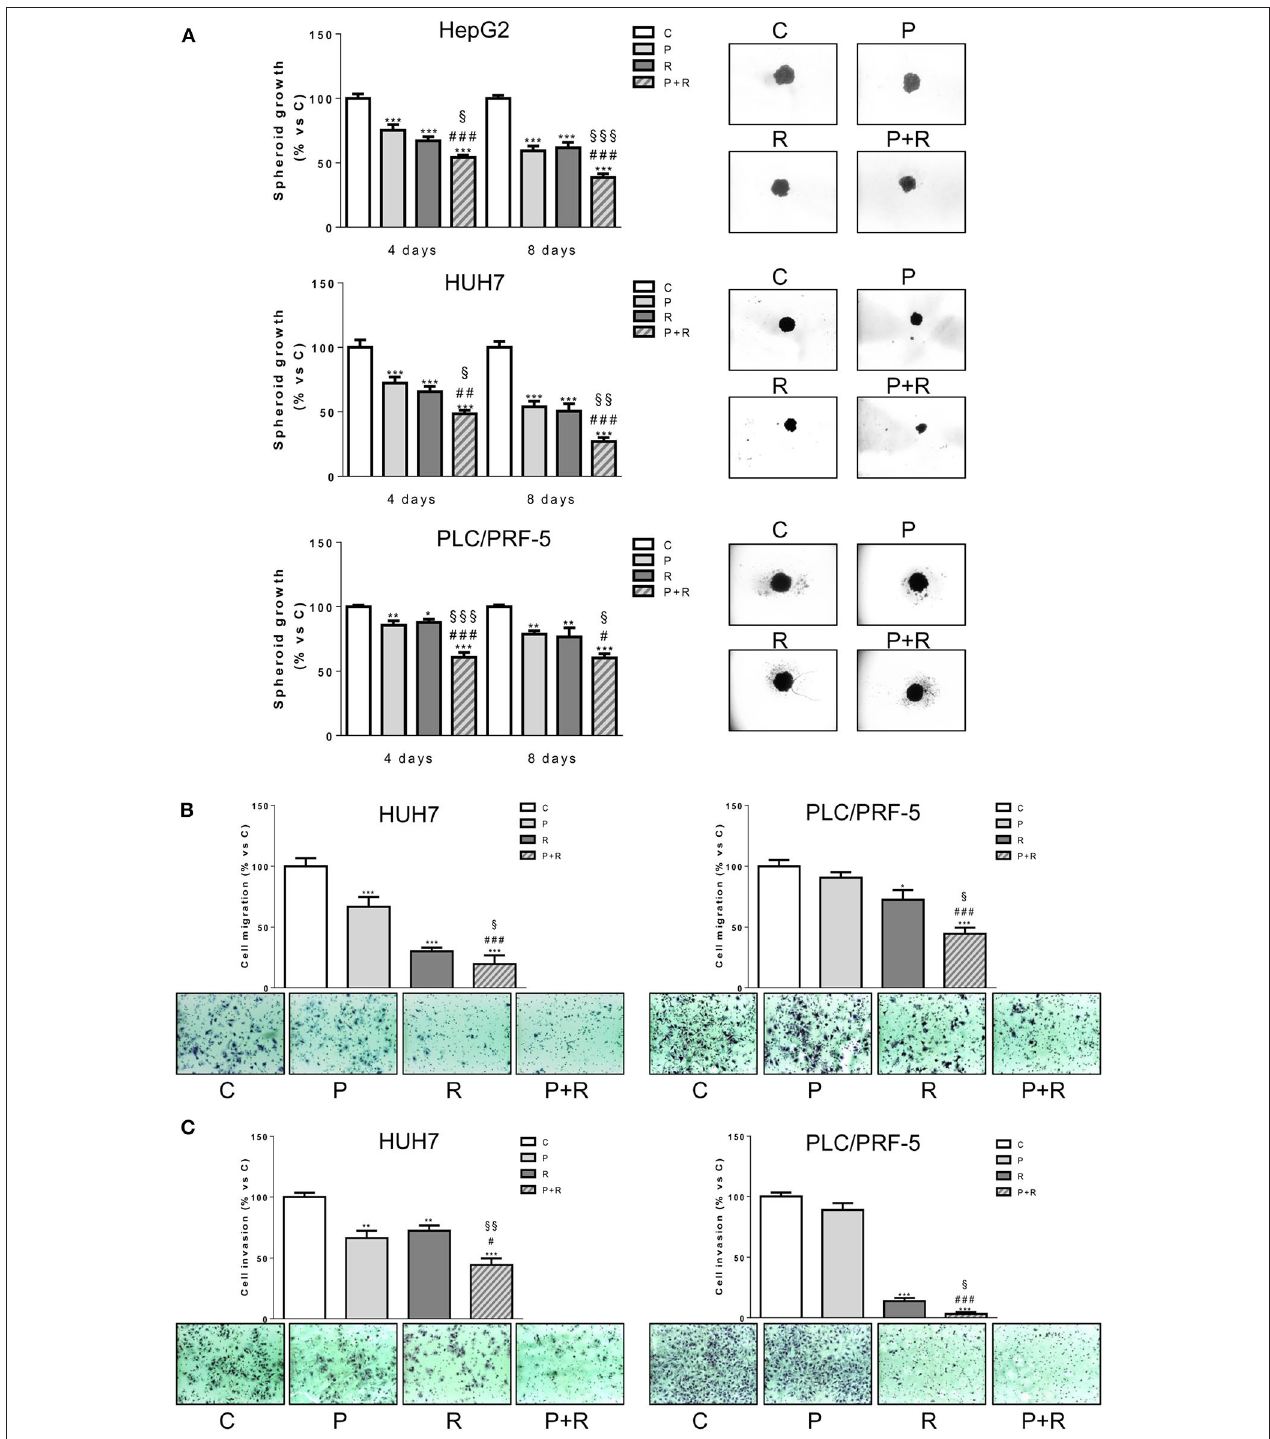
FIGURE 2 | Palbociclib combined with regorafenib inhibits 3D cell growth and reduces cell migration and invasion. (A) The growth of spheroids from HepG2, HUH7, and PLC/PRF-5 was analyzed after 4 or 8 days of treatment with 0.1 µ M P for HepG2 and HUH7, 0.5 µ M P for PLC/PRF-5, and 1, 1.5, or 7 µ M R for HepG2, HUH7, and PLC/PRF-5, respectively, as single treatment or in combination. The data are expressed as percent of spheroid growth vs. control. Representative images of spheroids after 8 days of culture are shown. * p < 0.05, ** p < 0.01, *** p < 0.001 vs. C, # p < 0.05, ## p < 0.01, ### p < 0.001 vs. P; § p < 0.05, §§ p < 0.01, §§§ p < 0.001 vs. R. (B,C) HUH7 and PLC/PRF-5 cells were treated with 1 µ M P or 1.5 µ M R for HUH7 and 7 µ M R for PLC/PRF-5, as single treatment or in combination for